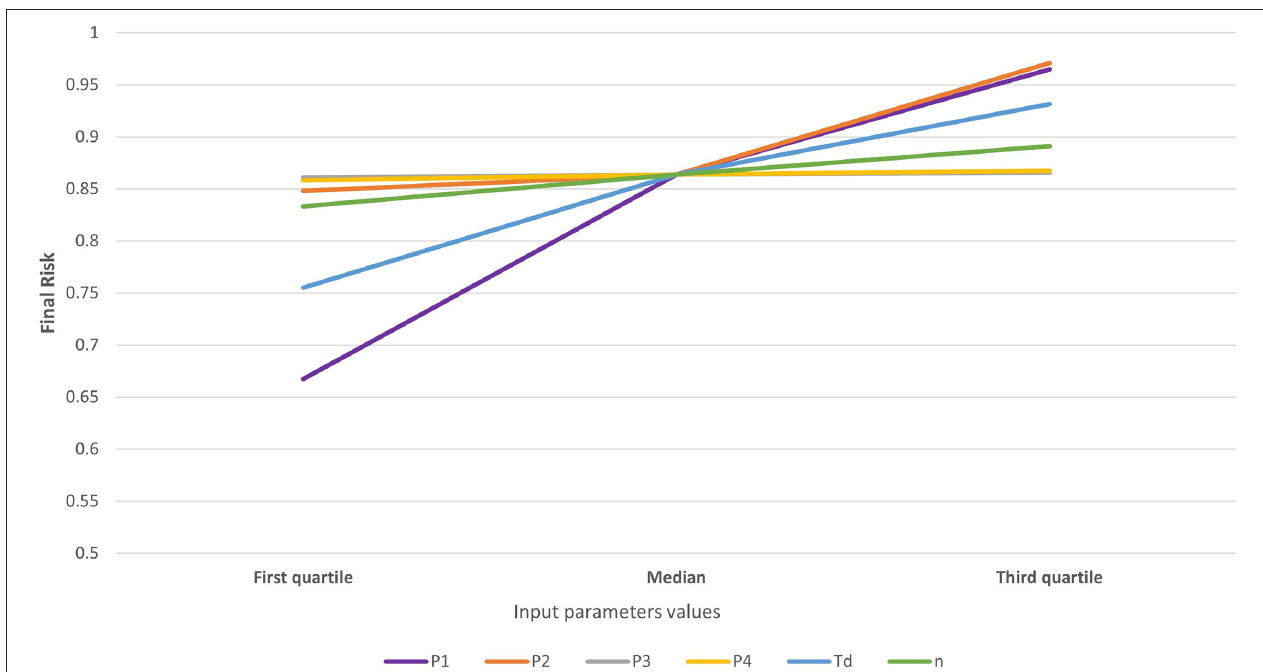
FIGURE 2 | Sensitivity to variations in the parameters of a risk assessment model for the introduction of CSF into MT. Model parameters are the probability of importing an infected pig (P1—purple line), the probability that an infected pig survives the infection before the shipment to MT (P2—orange line), the probability that an infected pig survives the shipment to MT (P3—gray line), the probability that an infected imported pig established contact with a susceptible pig in a farm in MT (P4—yellow line), the time-to-detect the outbreak (Td—blue line), and the number of pigs shipped into MT ( n —green